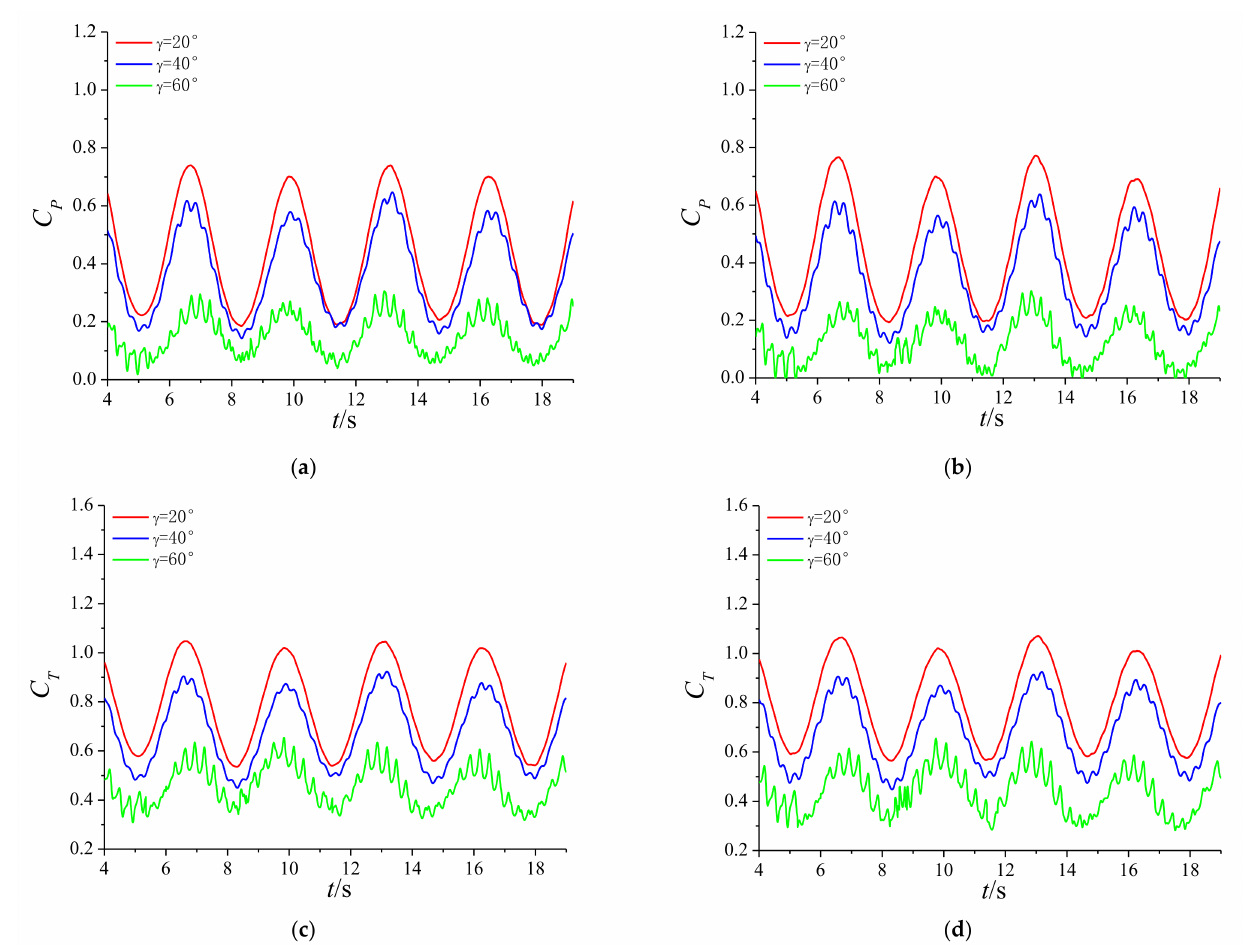
Figure 11. Time histories of C P and C T for the two configurations at different values of γ : ( a ) C P for DT; ( b ) C P for RDT; ( c ) C T for DT; ( d ) C T for